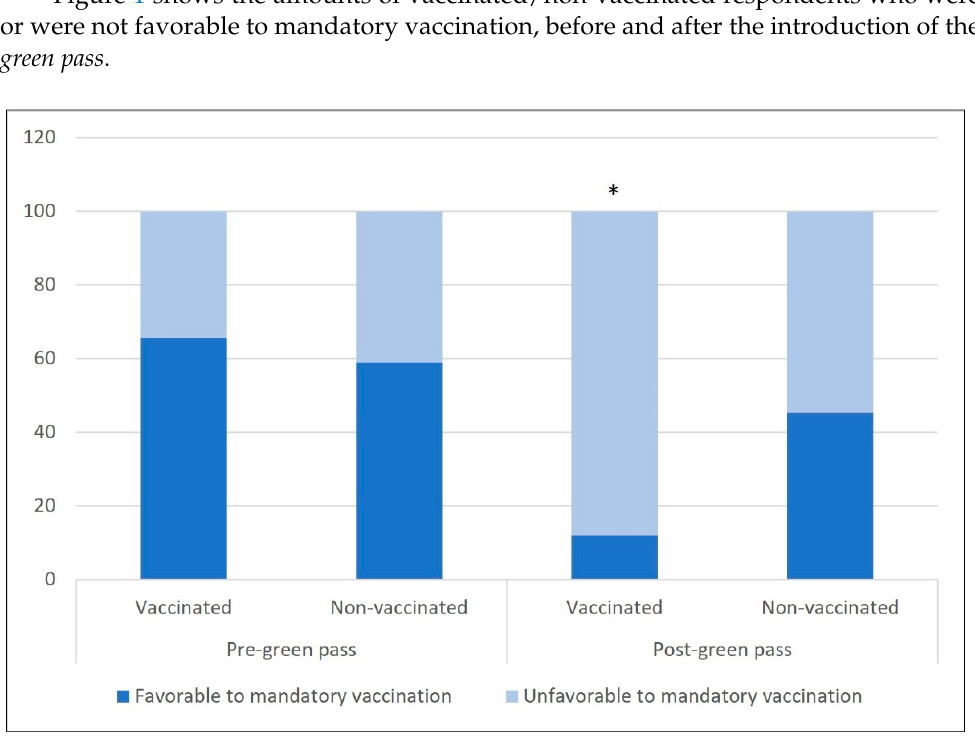
Figure 1. Proportions of respondents favorable or not to mandatory COVID-19 vaccination among vaccinated/non vaccinated respondents enrolled before and after the adoption of green pass. * p value < 0.05.